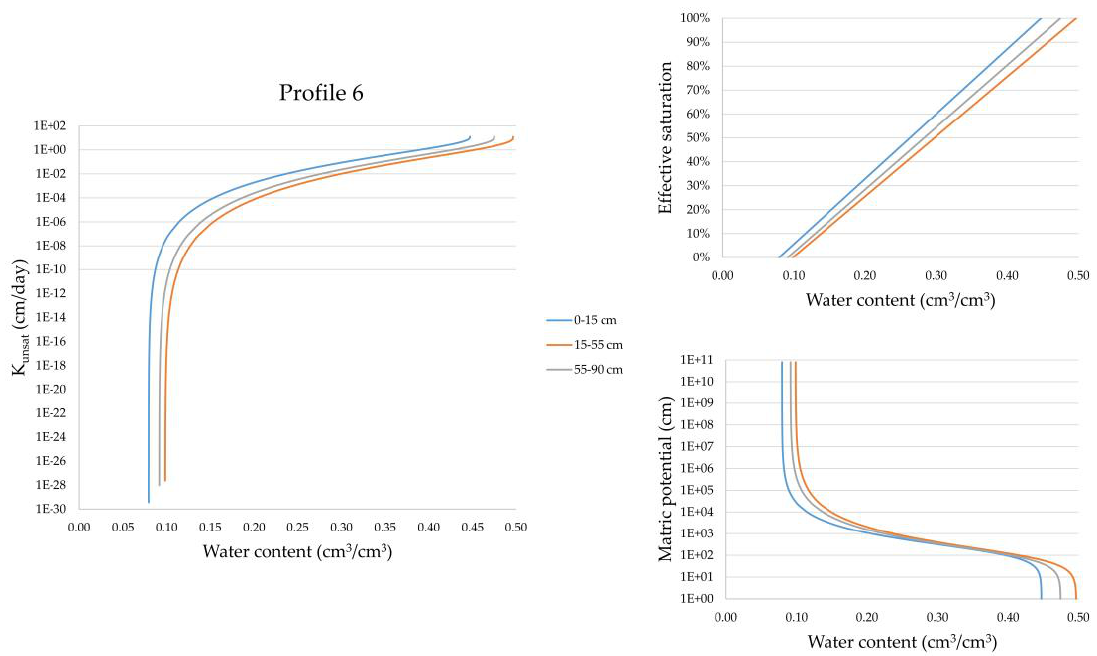
Geosciences 2019 , 9 , x FOR PEER REVIEW Figure 7. SWRCs, e ff ective saturations, and unsaturated hydraulic conductivities in soil profile 5. Figure 7. SWRCs, effective saturations, and unsaturated hydraulic conductivities in soil profile 5.